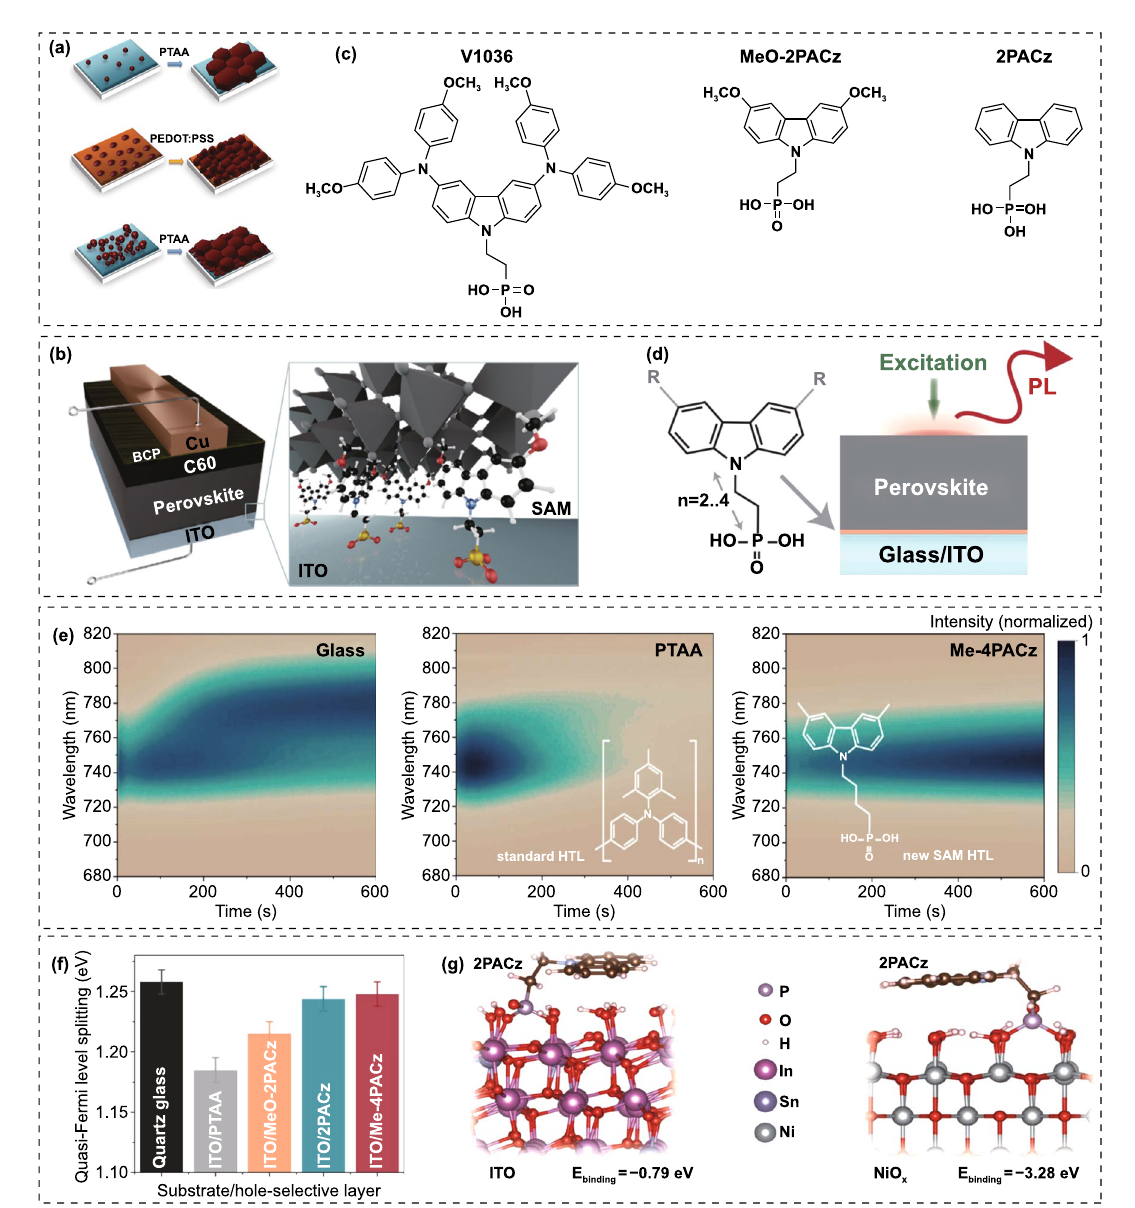
Fig. 11 a Schematic illustration of nucleation and growth of grains on wetting and non-wetting hole transport layer surface. Reproduced with permission from Ref. [176]. Copyright 2016, Wiley–VCH. b Schematic of the device structure. The zoom-in visualizes how the SAM molecules attach to the ITO surface and therefore enable the hole selective contact to the perovskite above. c Chemical structure of the SAM molecules V1036, MeO-2PACz and 2PACz. Reproduced with permission from Ref. [183]. Copyright 2019, Royal Society of Chemistry. d Schematic of PL experiment and chemical structure of a general carbazole-based SAM. e Time-dependent PL spectra of perovskite films on different substrates. f Quasi-Fermi level splitting values of nonsegregated perovskite films on glass substrate and different hole-selective layers. Reproduced with permission from Ref. [107]. Copyright 2020, Science Publishing Group. g Theoretical modeling of 2PACz adsorption on ITO (left) and NiO x (right) surfaces in the presence of surface hydroxyl groups based on DFT calculations. Reproduced with permission from Ref. [188]. Copyright 2022,